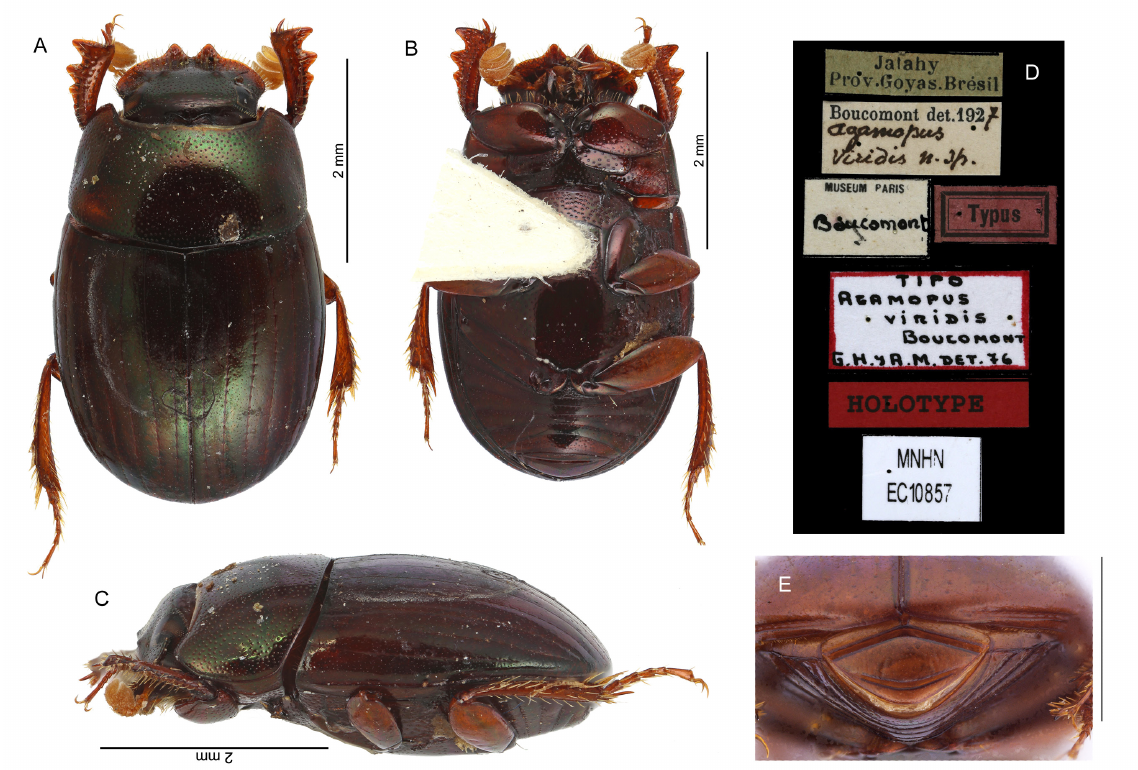
Fig. 9. A‒D . Agamopus viridis Boucomont, 1928. Holotype, ♀ (MNHN). A . Habitus, dorsal view. B . Habitus, ventral view. C . Habitus, lateral view. D . Labels. E . Sulcus of the pygidium in an